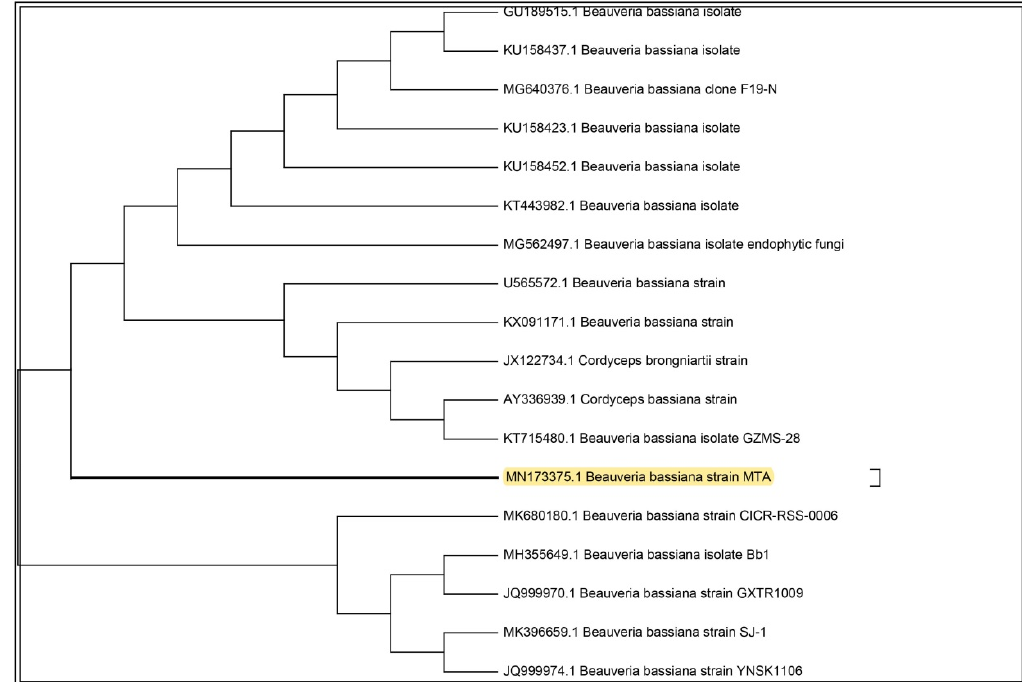
Figure 2. Phylogenetic tree of the isolated entomopathogenic Beauveria bassiana.